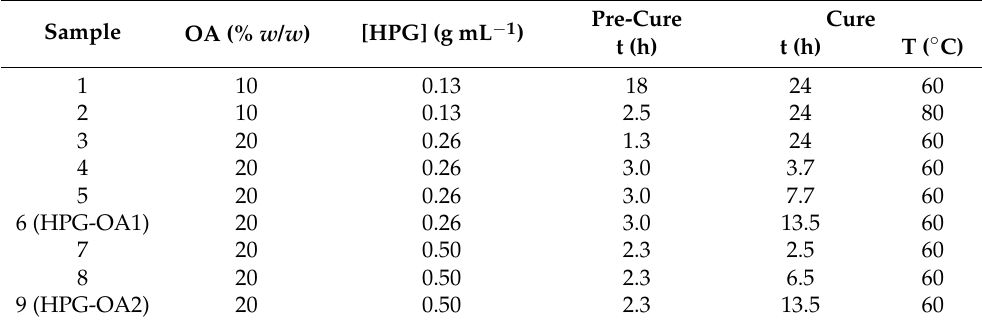
Table 1. Parameters of the study of hydrogel